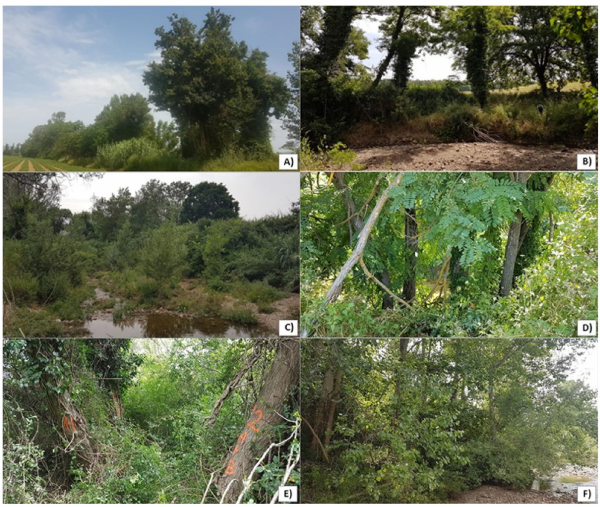
Figure 6. Vegetation pattern and distribution within the six test segments (capital letters correspond to the test area ID, Table